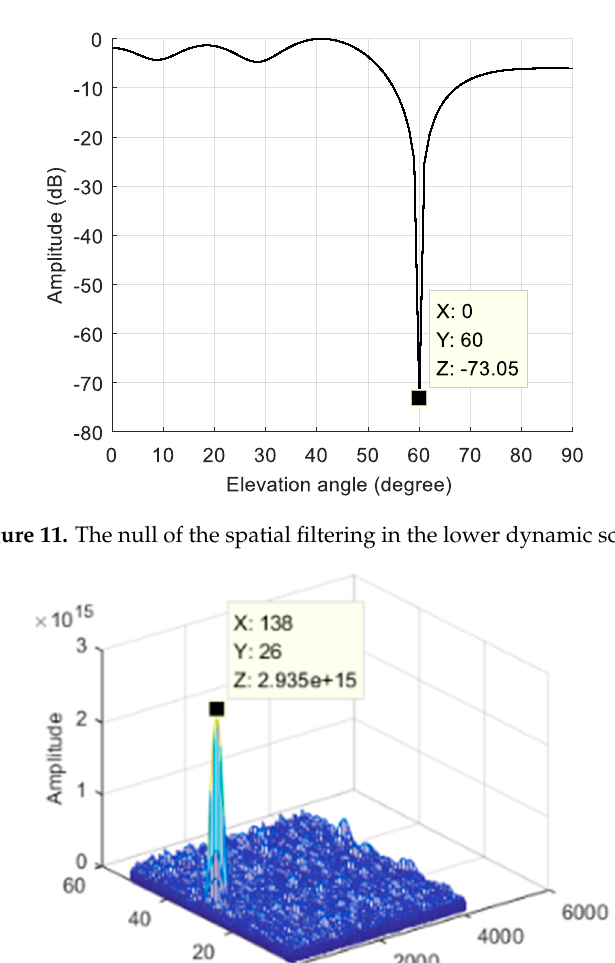
Table 3. Dynamic parameter setting.